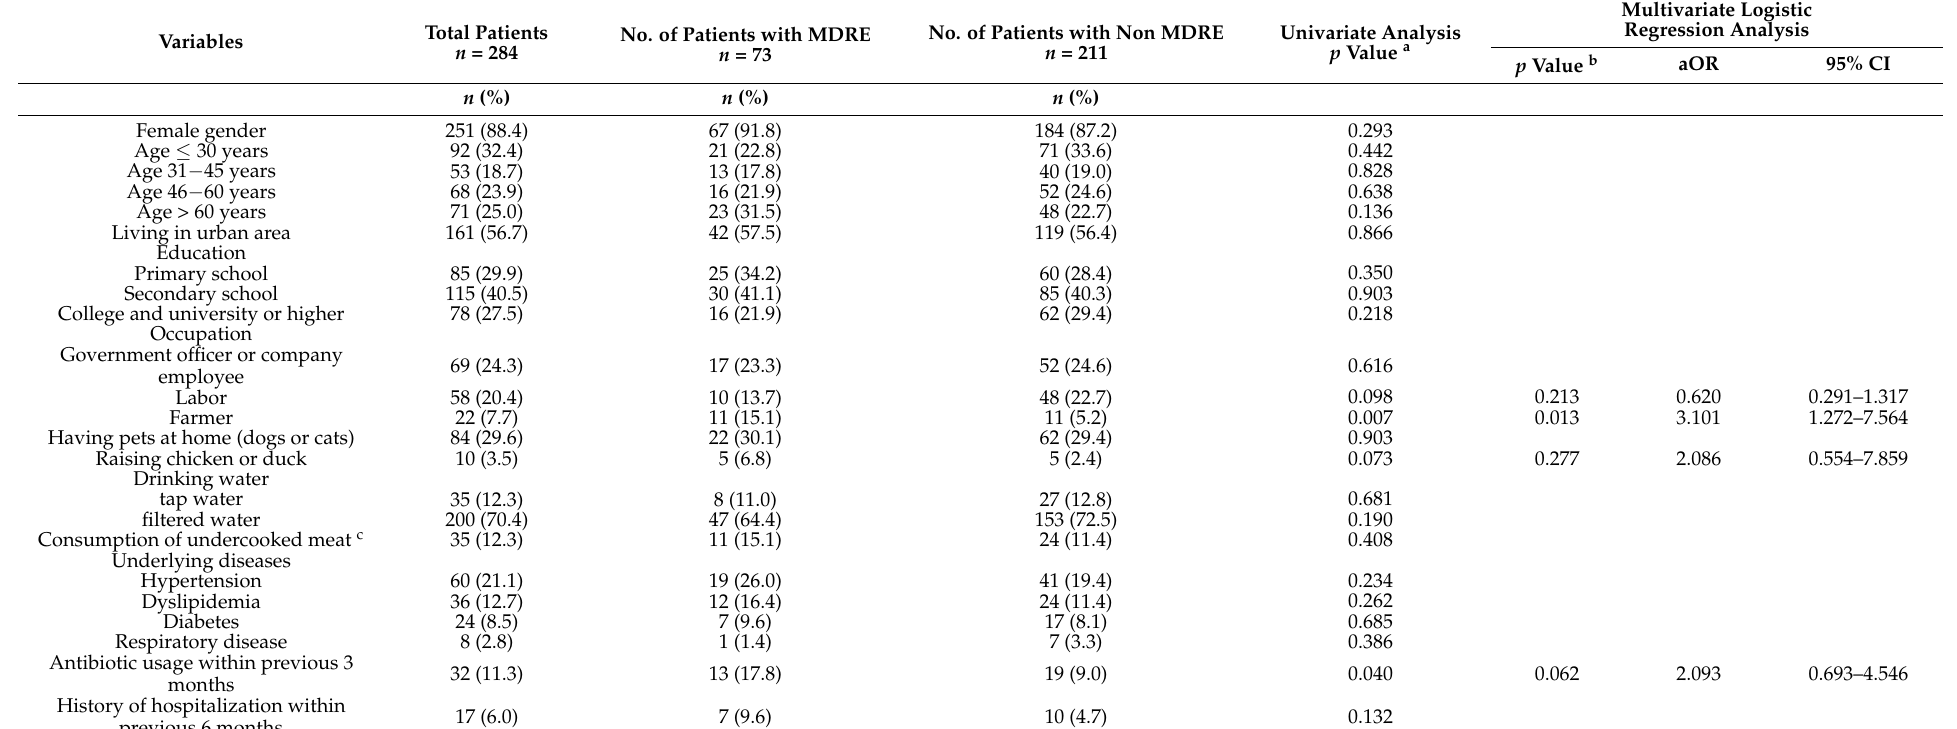
Table 1. Characteristics of patients with urinary tract infections caused by MDRE and